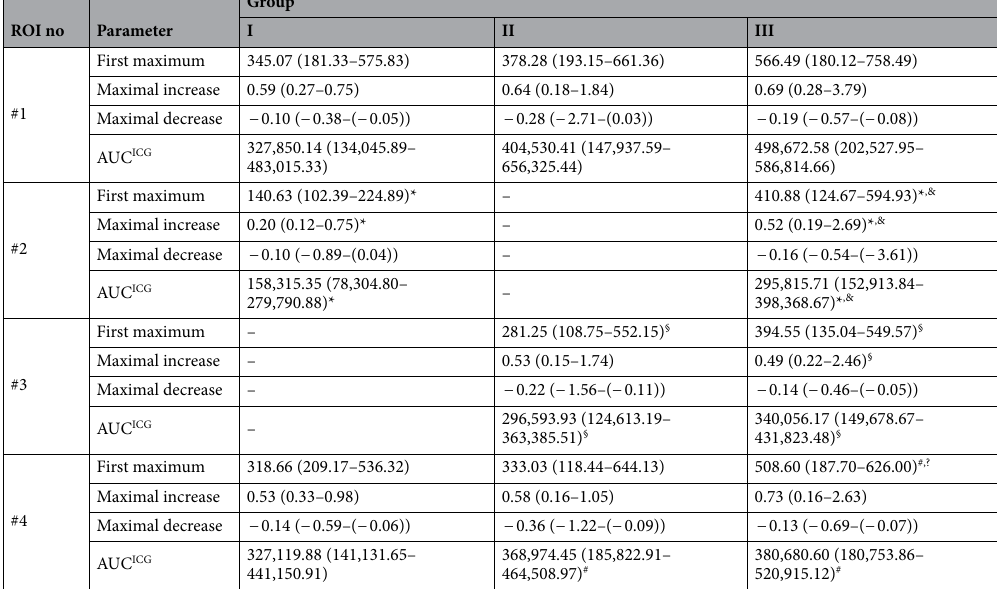
Table 3. Absolute values (arbitrary units, AU) and descriptive statistics of ICGVA for the three experimental groups: endothelial defect (ED group I), interposition vein graft (IVG, group II), and ED with IVG (group III). I defect, II interposition vein graft, III defect and interposition vein graft, ROI region of interest, AUC ICG area under the curve. Median (range). Wilcoxon test: significant ( p < 0.05) change in ROI 1 vs. 2, 3, and 4 (*, § , # ) within groups I–III and compared values. Mann–Whitney U test: significant ( p < 0.05) change between groups I vs. II, I vs. III, and II vs. III ( % , & , ? ) for the compared values.